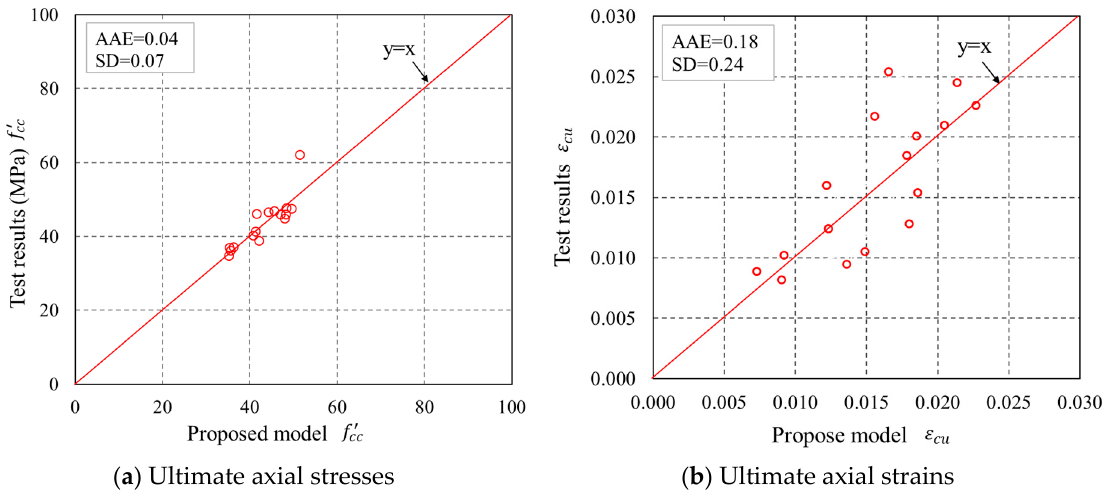
Figure 18. Performance of the proposed model in predicting the ultimate axial stresses and ultimate axial